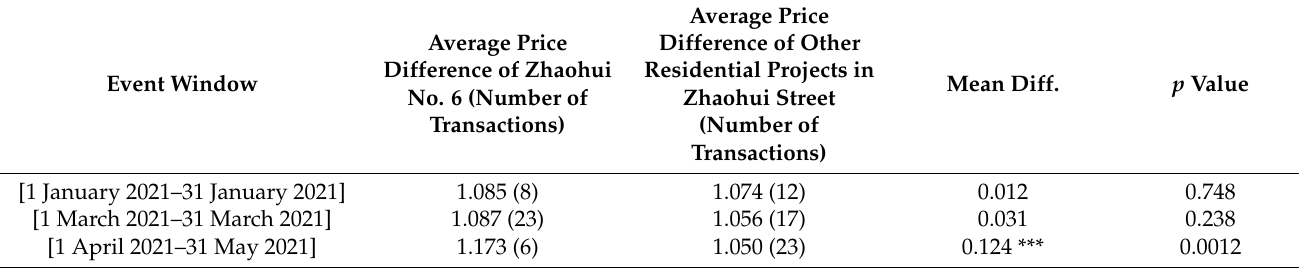
Table 4. Impacts on bargaining